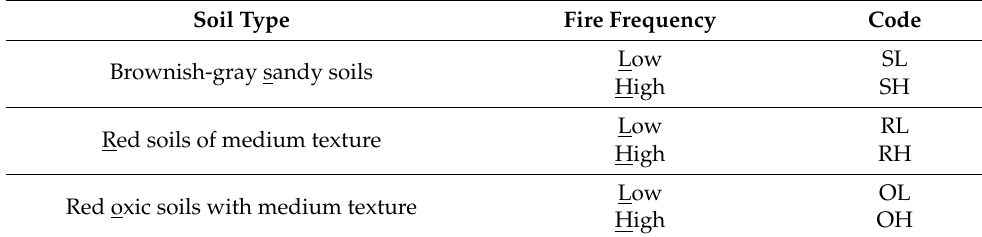
Table 1. Description of soil types and sample codes (underlined